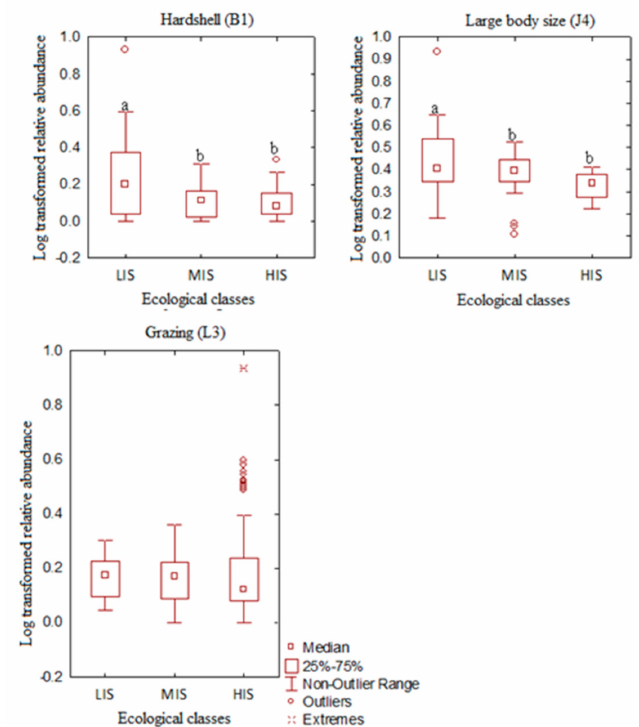
Figure 3. Pattern of distribution of sensitive traits across the three ecological classes in the present study.